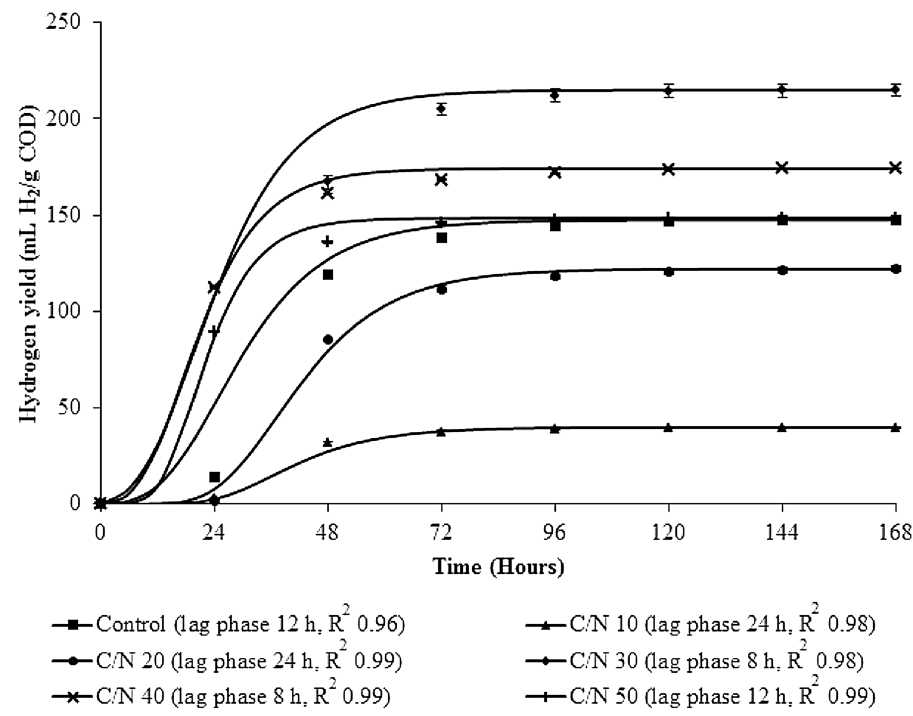
Fig. 2 Effect of C/N ratio on thermophilic biohydrogen